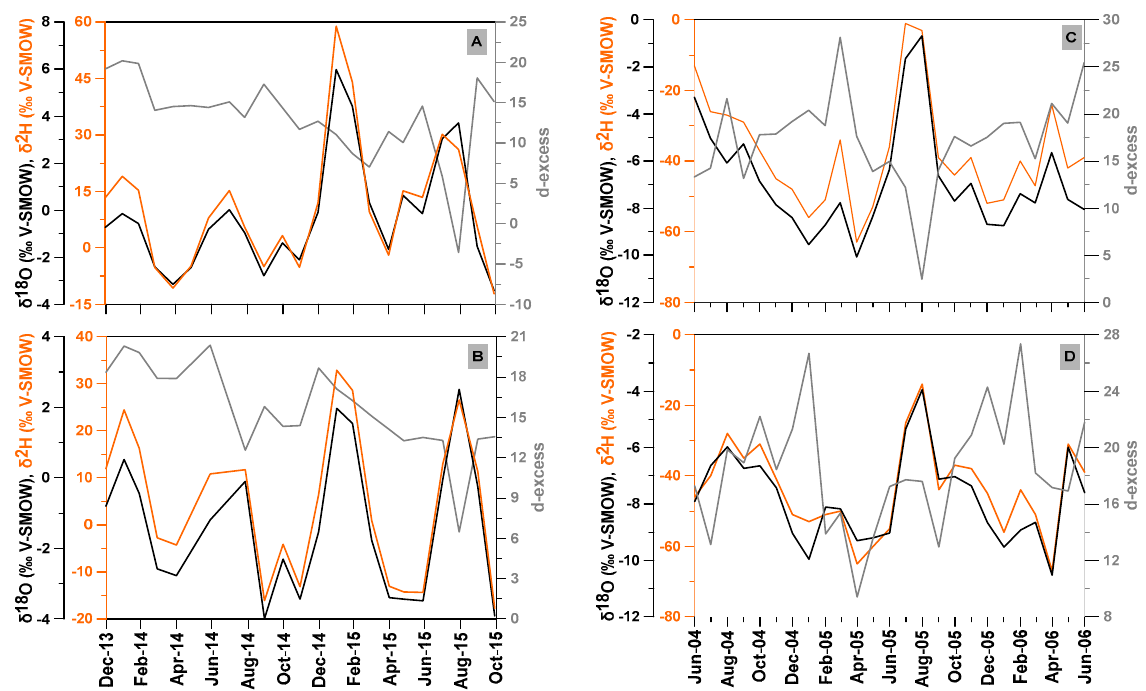
Figure 3. Temporal variation of δ 2 H, δ 18 O and d-excess in monthly precipitation in Virunga ( A , B ), located on the limit between Central and Eastern Africa, within the western branch of the East African Rift System,and in the Central Mediterranean ( C , D ), Sicily in sourthern Italy.